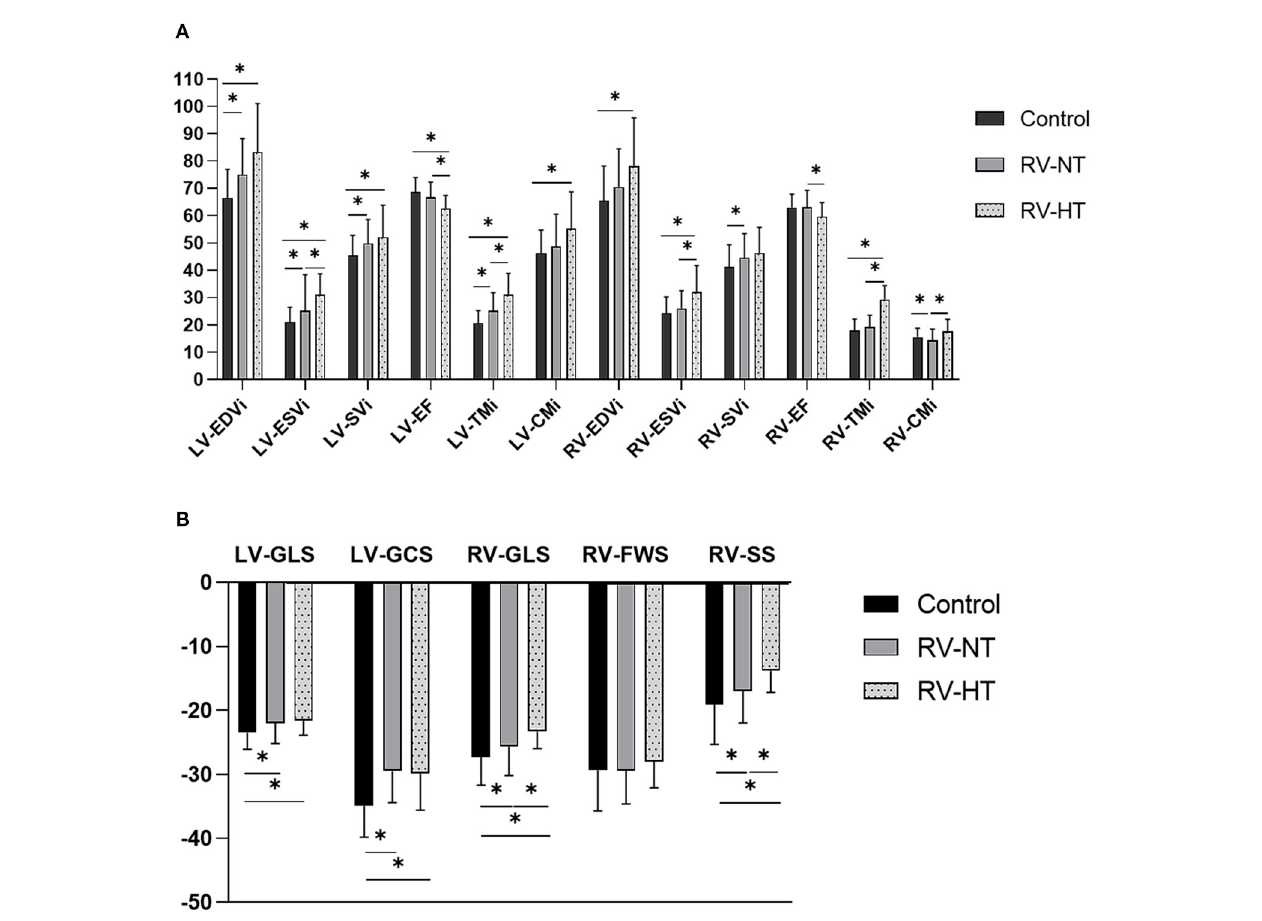
FIGURE 2 | Graphic representation of Table 2 . Comparison of the left and right ventricular volumetric and functional (A) and strain (B) parameters of LVNC patients with right ventricular hypertrabeculation, patients with normal right ventricular trabeculation, and controls. CMi, compacted myocardial mass index; EDVi, end-diastolic volume index; EF, ejection fraction; ESVi, end-systolic volume index; FWS, free-wall strain; GCS, global circumferential strain; GLS, global longitudinal strain; LV, left ventricle; LVNC, left ventricular non-compaction; RV, right ventricle; RV-HT, patients with right ventricular hypertrabeculation; RV-NT, patients with normal right ventricular trabeculation; SS, septal strain; SVi, stroke volume index; TMi, trabeculated myocardial mass index. * p <